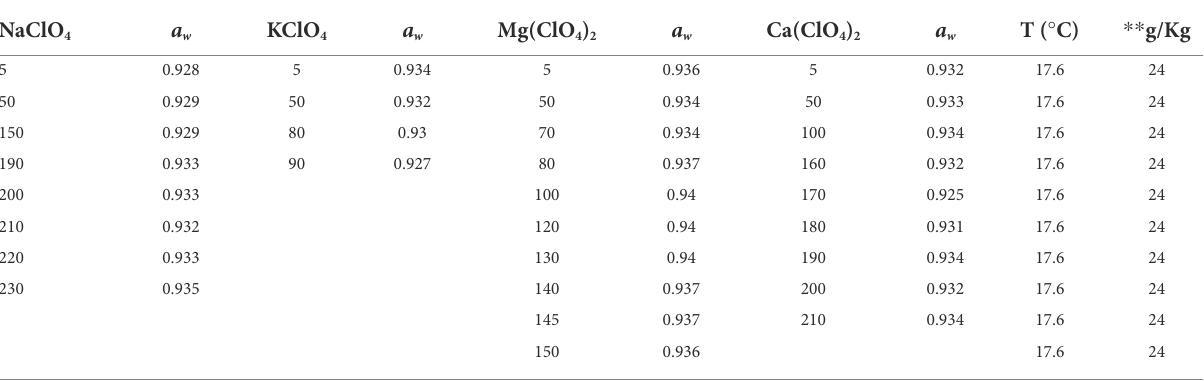
TABLE 2 Water activity ( a w ) values in perchlorates salt